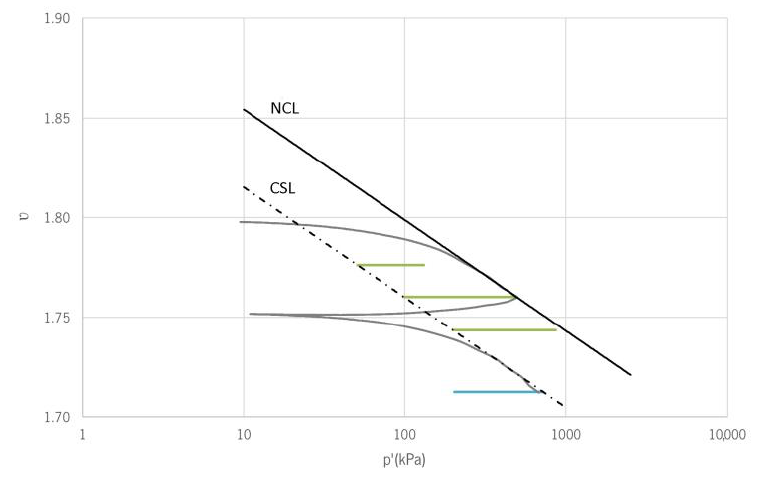
Figure 18. Isotropic consolidation curve with respective NCL and CSL (stabilized MT).